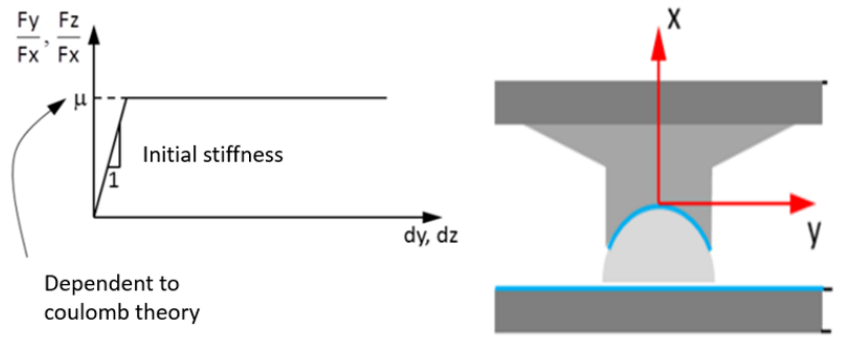
Figure 10. Flat slider bearing element. Table 5. Details of the modeling of the LRBP.